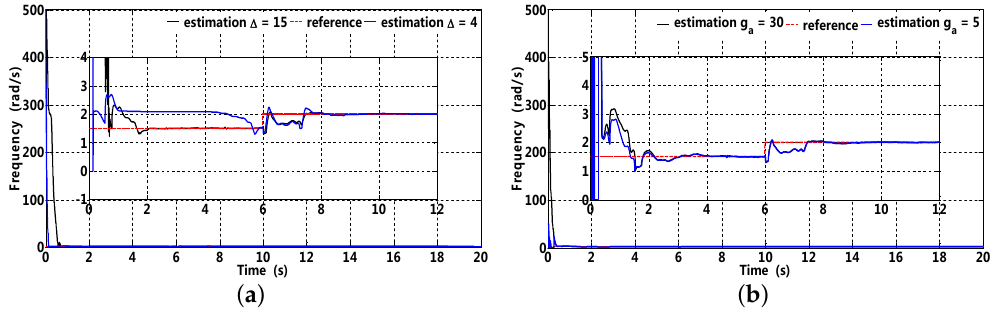
Figure 16. Frequency estimation with respect to parameter ∆ and g a .( a ) ∆ ; ( b ) g a